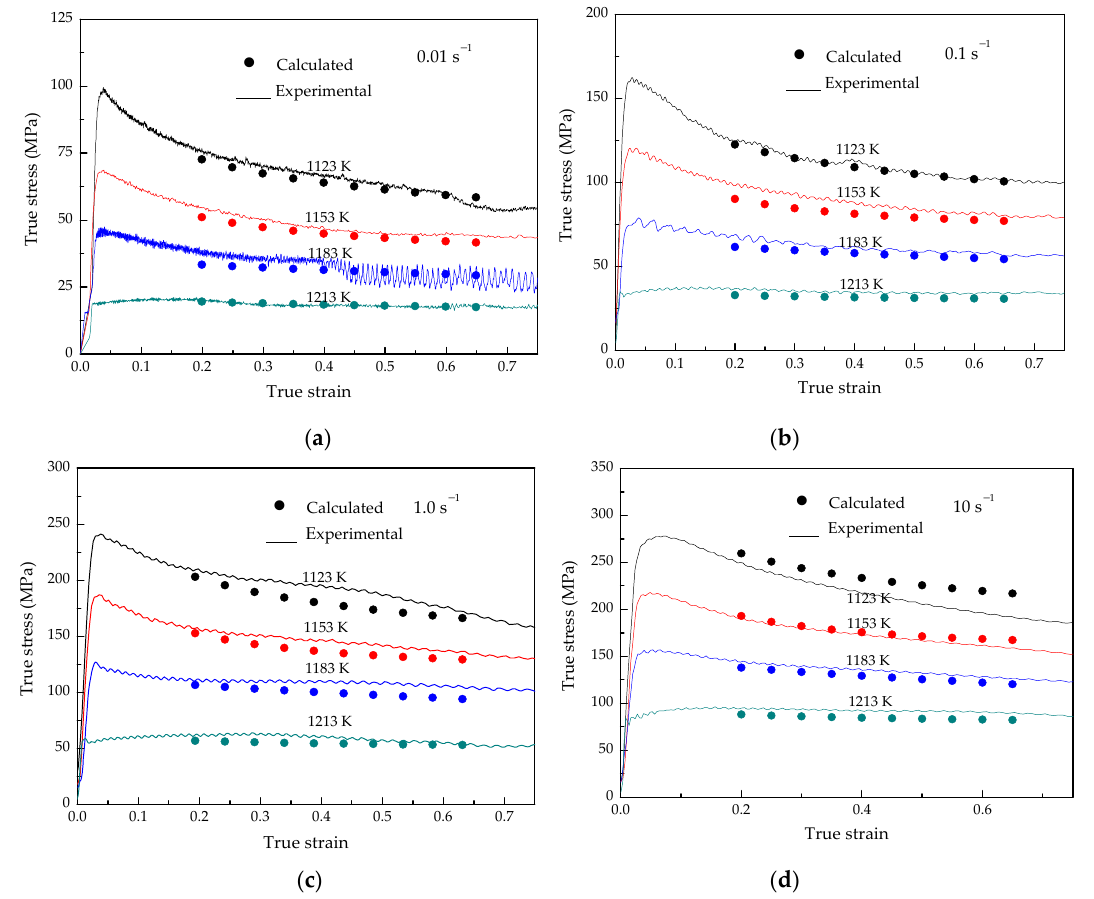
Figure 10. Comparison of the calculated with the experimental flow stress: ( a ) 0.01 s − 1 , ( b ) 0.1 s − 1 , ( c ) 1.0 s − 1 and ( d ) 10 s − 1 .